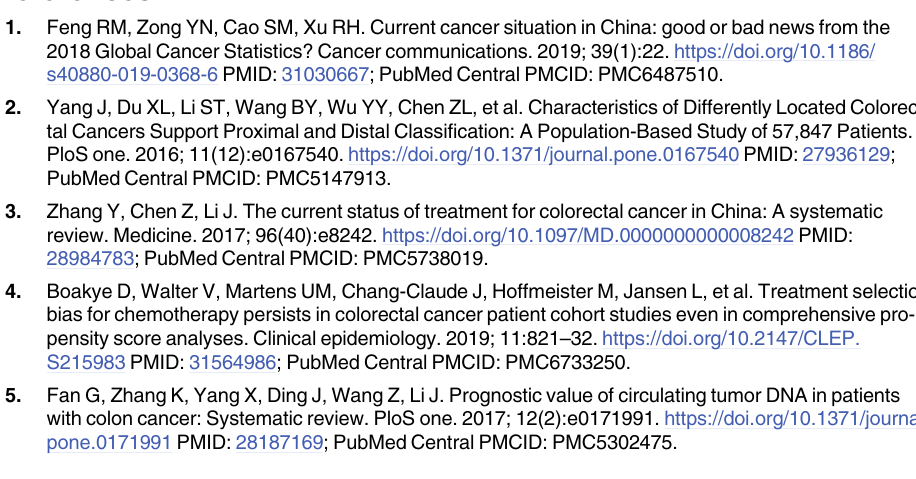
S1 Table. A total of 210 autophagy genes. S2 Table. The results of functional enrichment